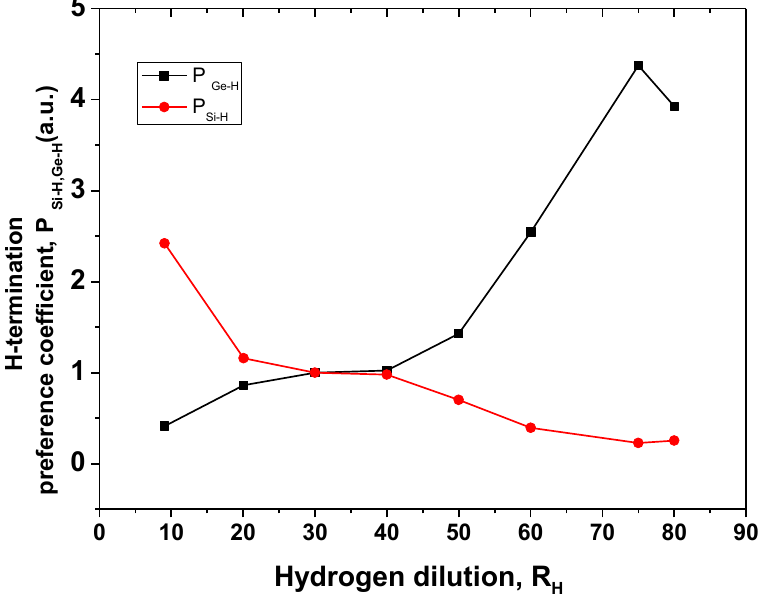
Figure 8. Factor of preferential H- termination for Si–H and Ge–H bonds in the Si–Ge:H films deposited with different H-dilution.